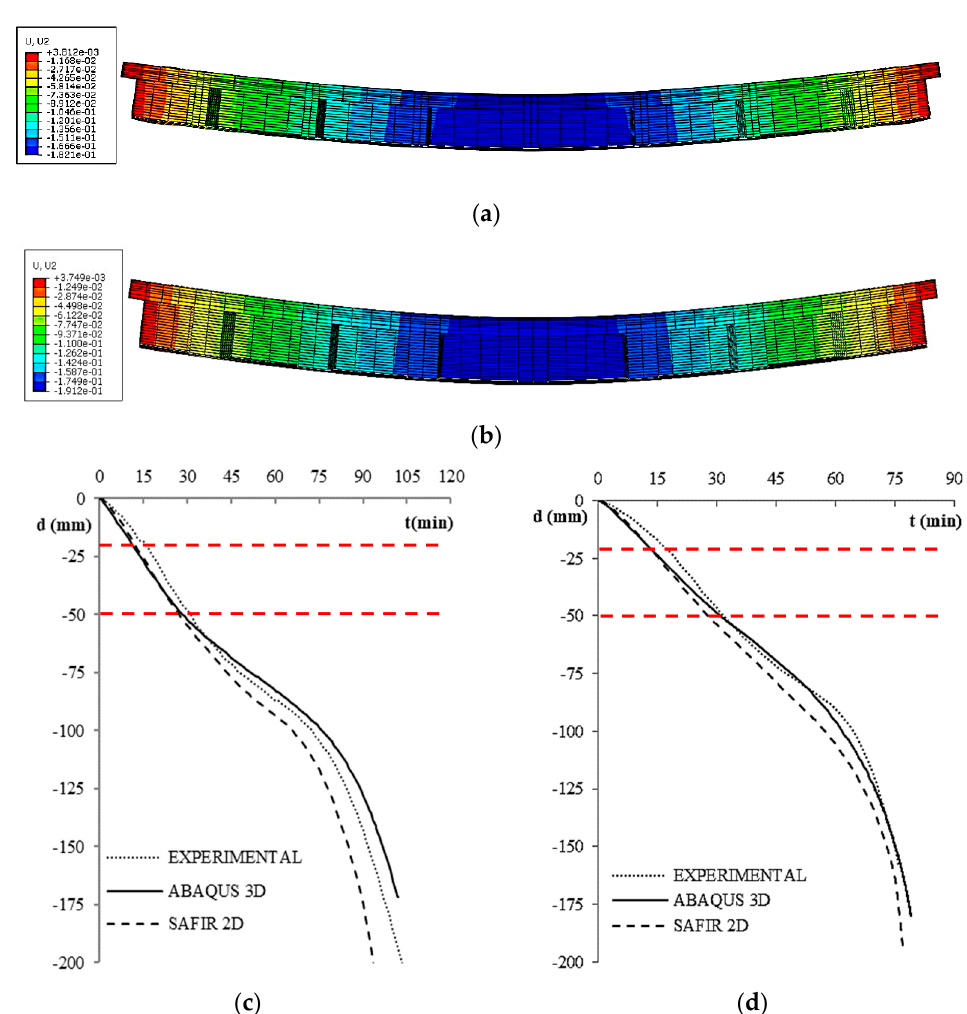
Figure 8. Experimental vs. predicted mid-spand deflections for 2D and 3D FEM: ( a ) Deflected shape of WFRC 66162 after 102 min, ( b ) Deflected shape of WFRC 67756 after 79 min, ( c ) Mid-span deflection, Test vs. FEM for WFRC 66162, ( d ) Mid-span deflection, Test vs. FEM for WFRC 67756.